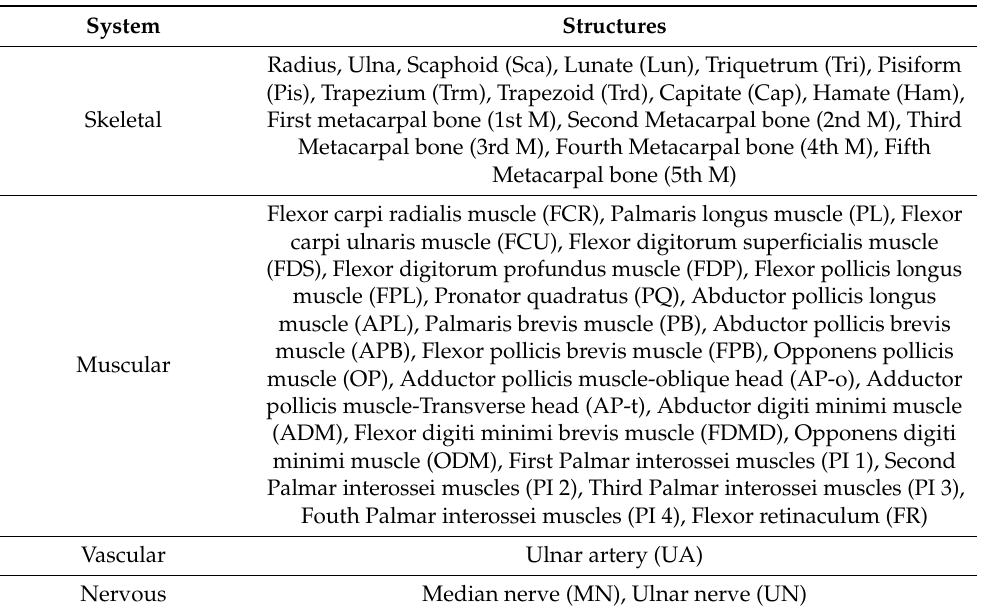
Figure 1. Image processing method of the ultrasound ( A ) and Schematic of the ultrasound scanning levels of the palmar wrist ( B ). Transverse section scanning was performed from the distal forearm to the metacarpal bases along the reference lines (red and green) at 3 mm intervals. Table 1. Labeled structures in sectioned images and US